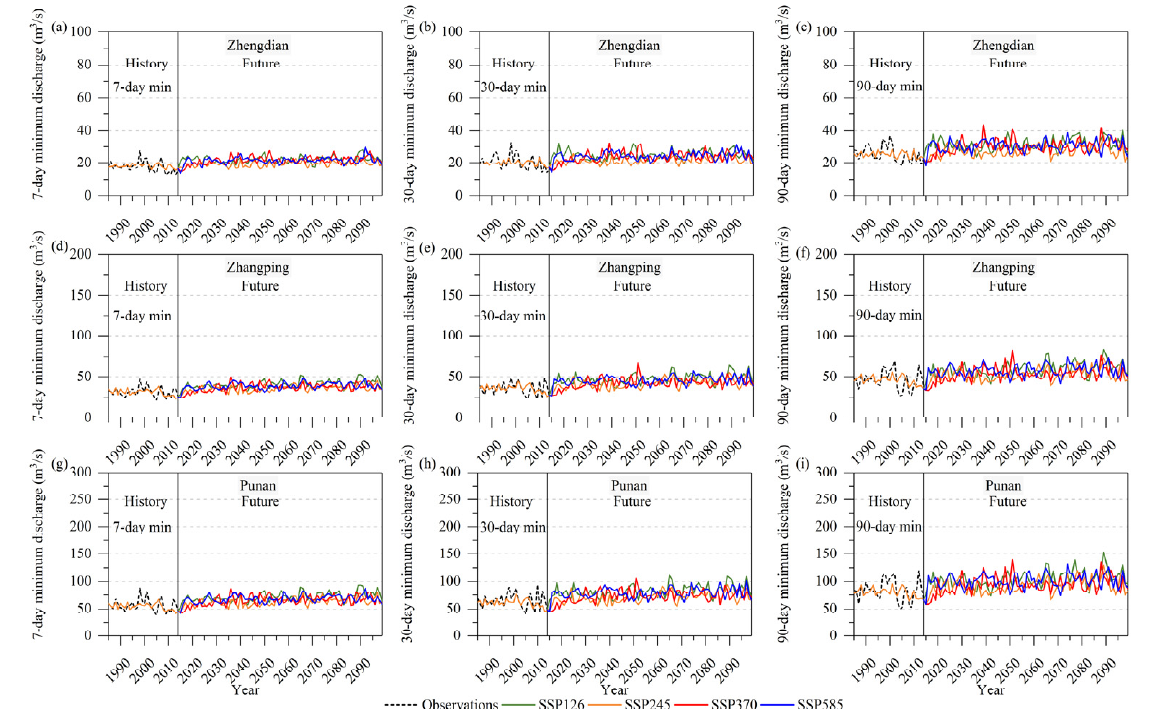
Figure 8. Simulated annual 7-day minimum, 30-day minimum and 90-day minimum river dis- charges in the historical period and under the future SSP–RCPs at Zhengdian ( a – c ) station, Zhang-